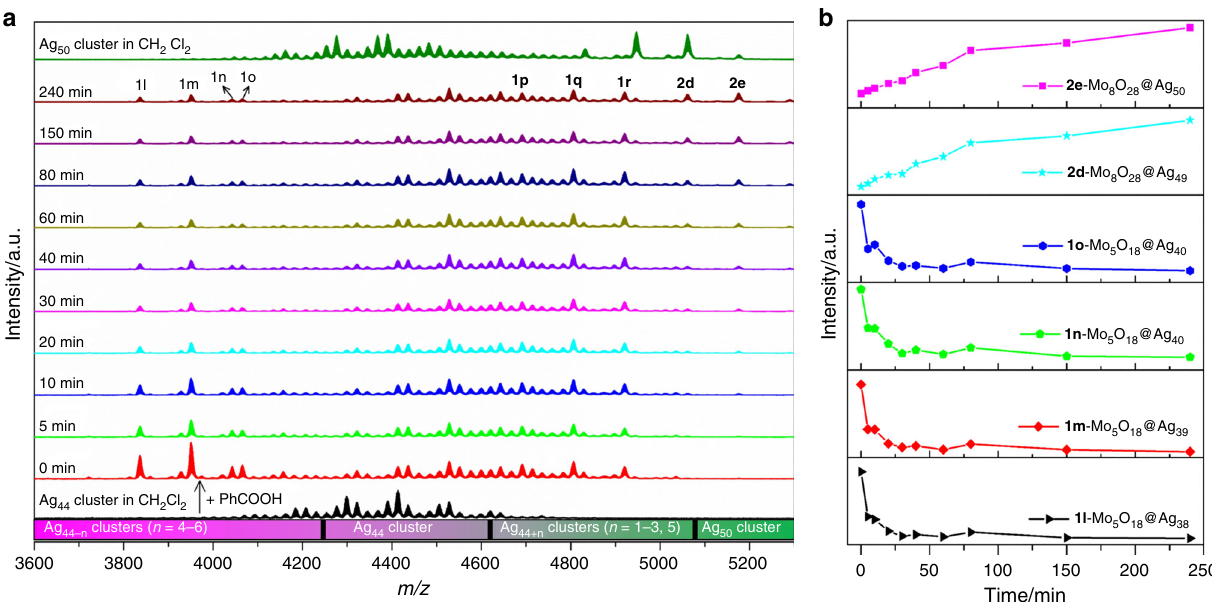
Fig. 5 Time-course ESI-MS. a Time-course ESI-MS of transformation from Ag 44 to Ag 50 cluster induced by adding PhCOOH. The detailed formulae of labeled species are listed in Supplementary Table 6. b Plots of ESI-MS peak intensity of selected intermediate species vs time during the transformation